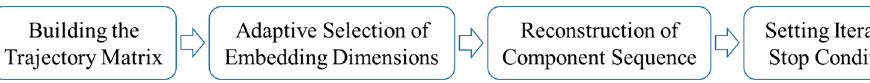
Figure 1. Specific process of the SSD